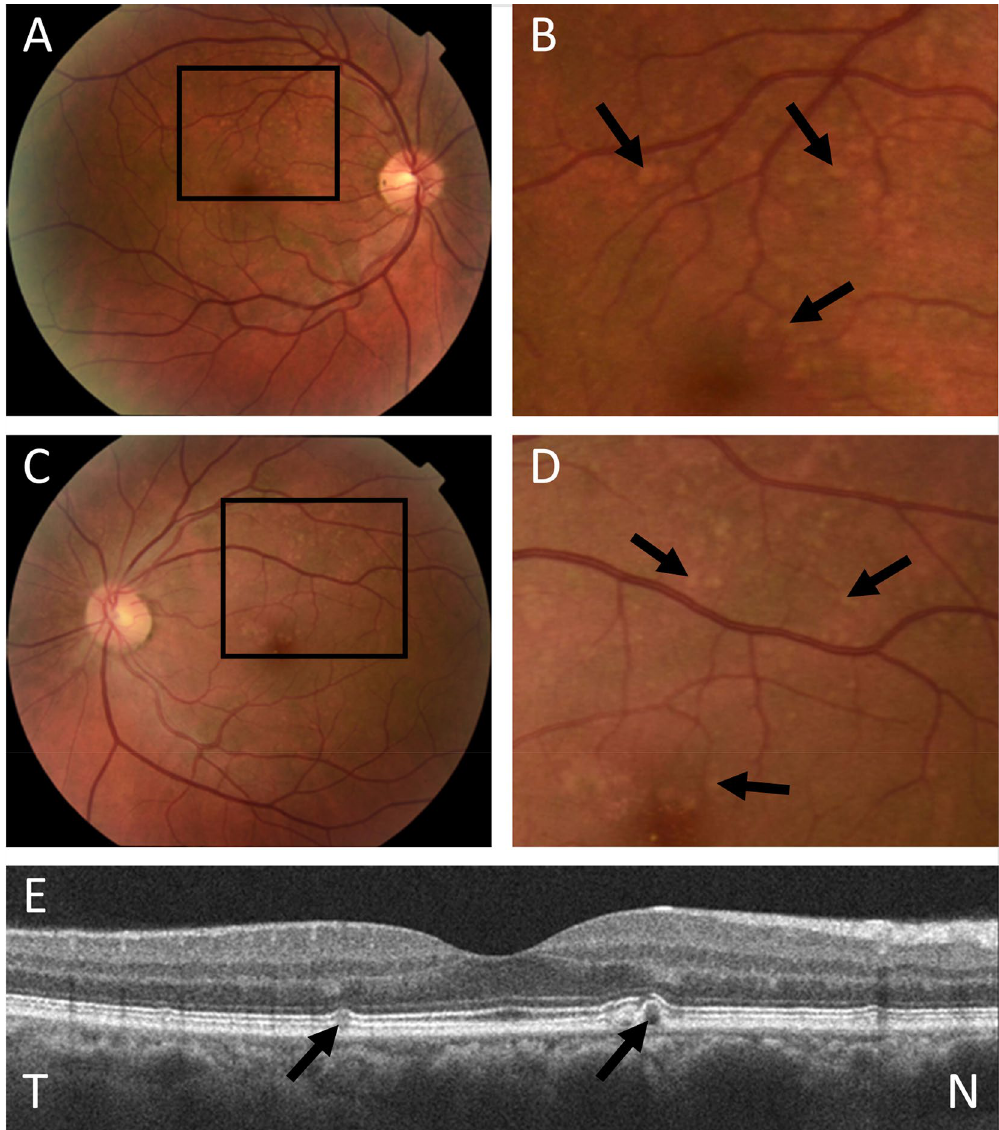
Figure 2. Drusen in a 50 year old man with FSGS. ( A ) Colour fundus photograph of right eye; ( B ) Magnified view demonstrating small, medium and large drusen (arrows) at the central macula; ( C ) View of left eye; ( D ) magnified view with drusen (arrows); ( E ) Optical Coherence Tomography (OCT) of the right eye demonstrating sub-retinal pigment epithelial drusen (arrows) and a break in the photoreceptor layer overlying the nasal drusen